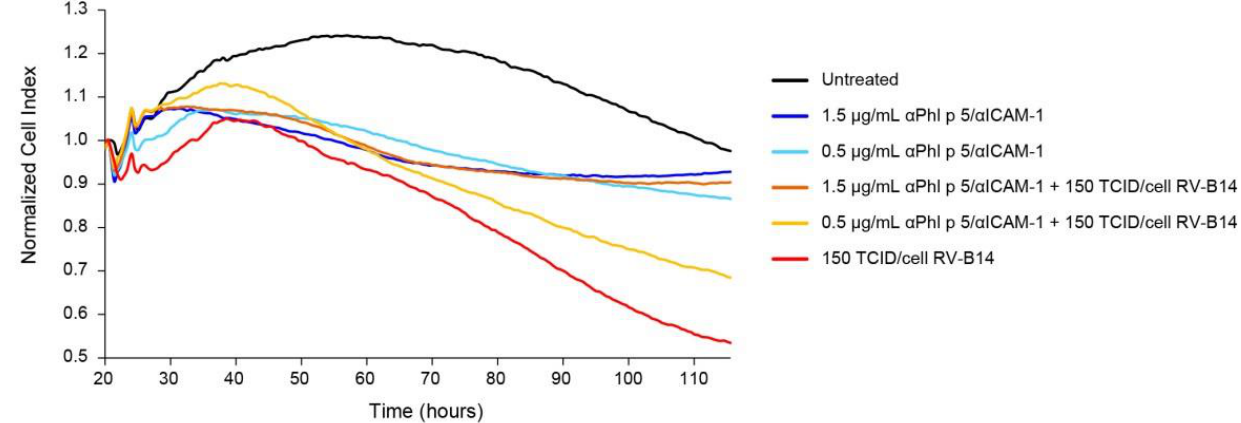
Figure 6. Treatment with αPhl p 5/αICAM -1 conjugates protects epithelial cells against damage by RV infection. The 16HBE14o- cells were cultured on e-plates of the xCELLigence DP system and were incubated with different concentrations of αPhl p 5/αICAM -1 conjugates (0.5 µg/mL and 1.5 µg/mL) or medium. Three hours thereafter, cells were infected with 150 TCID 50 /cell of RV-B14. Cells that were not infected with RV-B14 served as controls (untreated, 0.5 µg/mL and 1.5 µg/mL αPhl p 5/αICAM -1). Impedance values were automatically measured every 30 minutes (min) by the xCELLigence DP system for 120 h and are expressed as a normalized cell index ( y -axis). Data are shown as mean values of triplicates for each measuring point and are representative of two inde- pendent experiments.